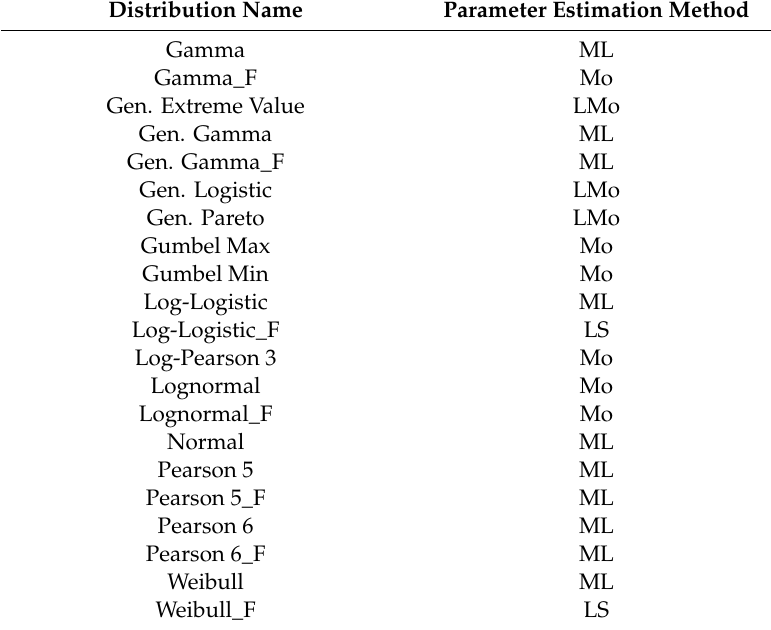
Table 1. Di ff erent Distributions and their parameter estimation methods used in this